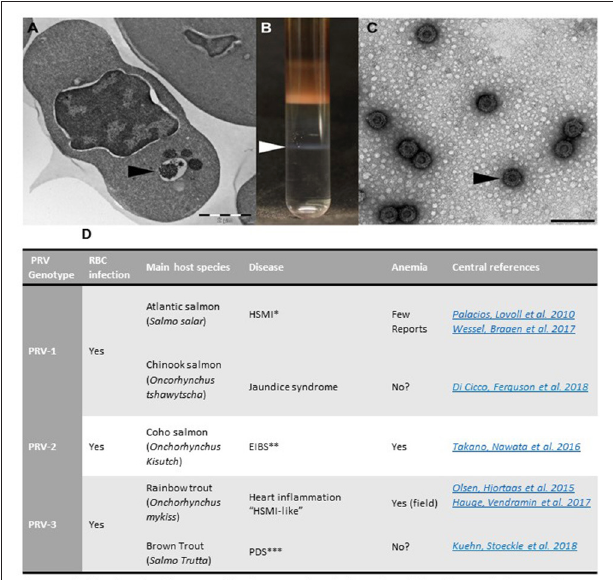
FIGURE 1 | Purification of PRV from infected RBCs and PRV genotypes. (A) Micrograph of PRV infected erythrocyte with virus-containing inclusions in the cytoplasm (arrowhead). (B) Purification of PRV from infected blood cells results in virus band in CsCl gradient. (C) Electron microscopy image of purified PRV particles (Bar equals 100nm). (D) Overview of PRV genotypes and associated